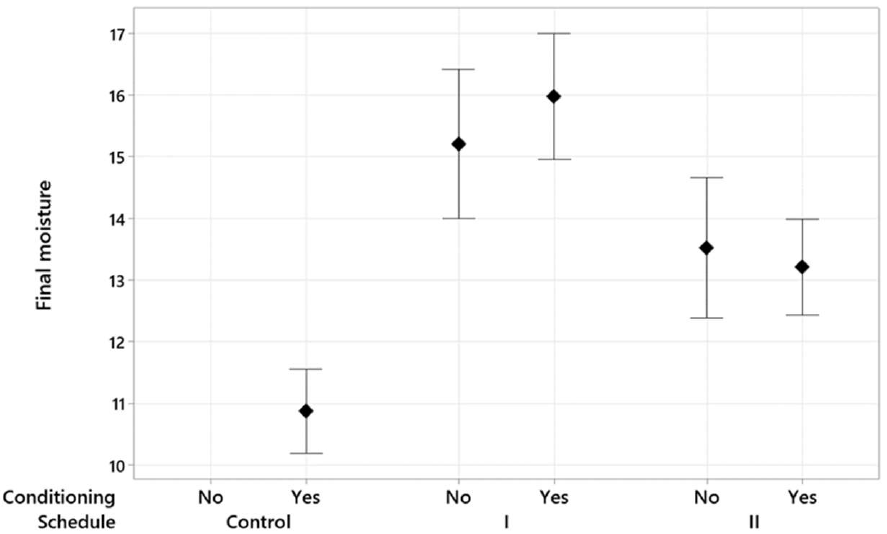
Figure 2. Interval plot of the M f for different drying schedules with the presence and absence of conditioning treatment. The results are at 95% of the confidence interval for the M f mean.